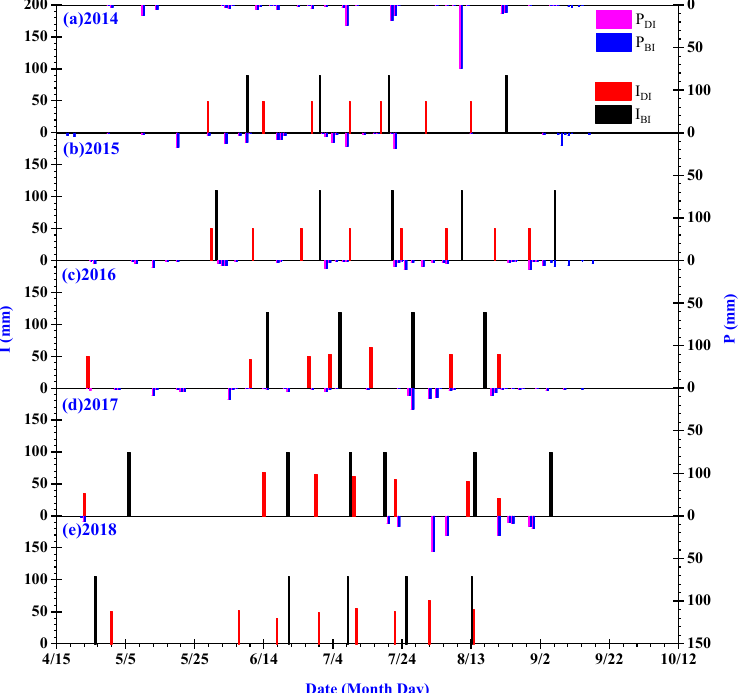
Figure 2. Seasonal variations of precipitation (P) and irrigation (I) over the maize field from 2014 to 2018 under film mulching border irrigation (BI) treatment and film mulching drip irrigation (DI) treatment. Table 1. Water balance components, D/(P+I), T/(P+I) (CWUE), Y/I (IWUE) and Y/ET (WUE) under film mulching border irrigation (BI) and film mulching drip irrigation (DI) during 2014–2018 and p value by t -test of these.